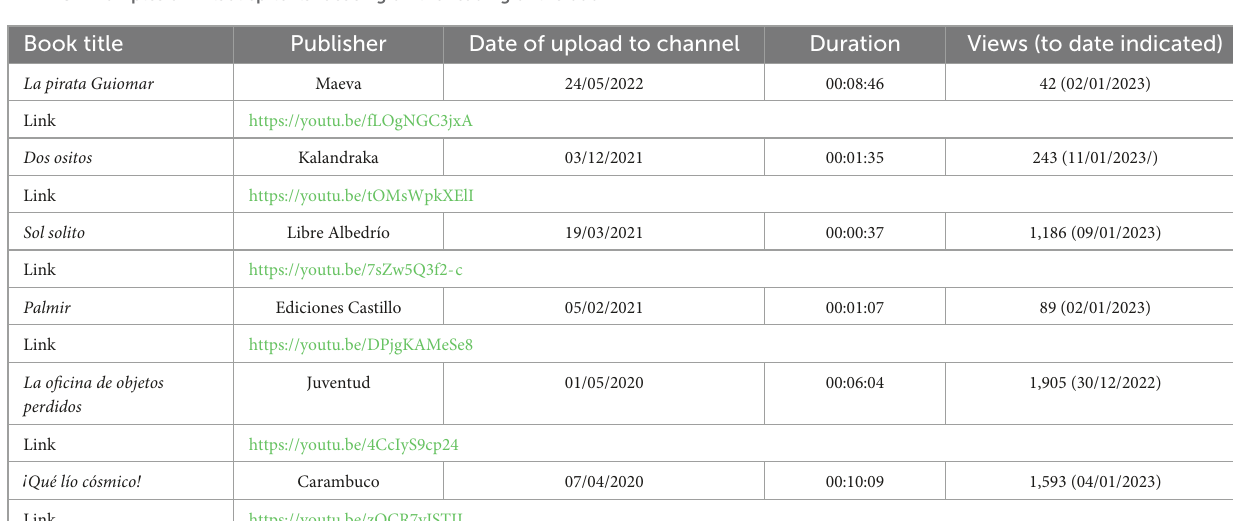
TABLE 9 Examples of virtual epitexts focusing on the reading of the